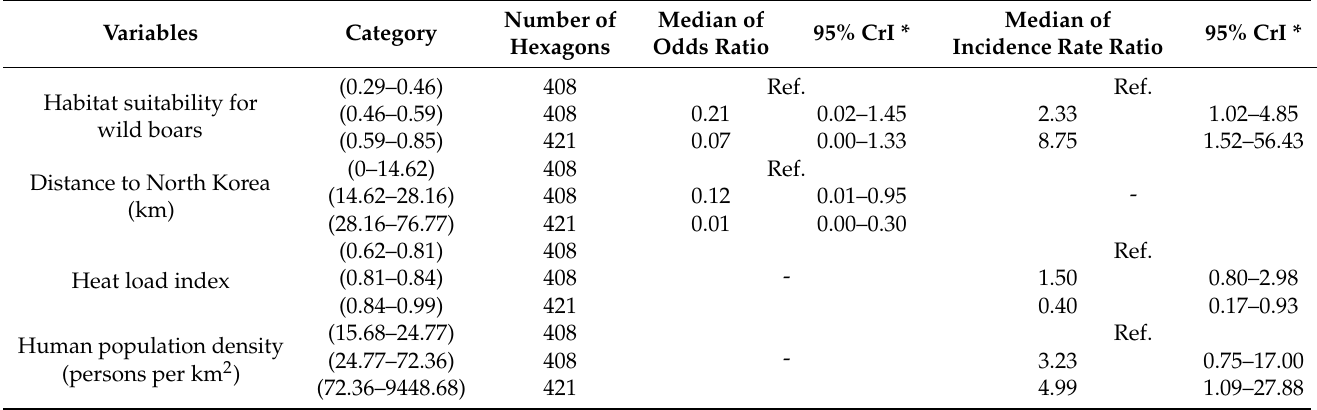
Table 2. Results of the spatial zero-inflated Poisson model for the first period (from 2 October 2019 to 18 January 2020).